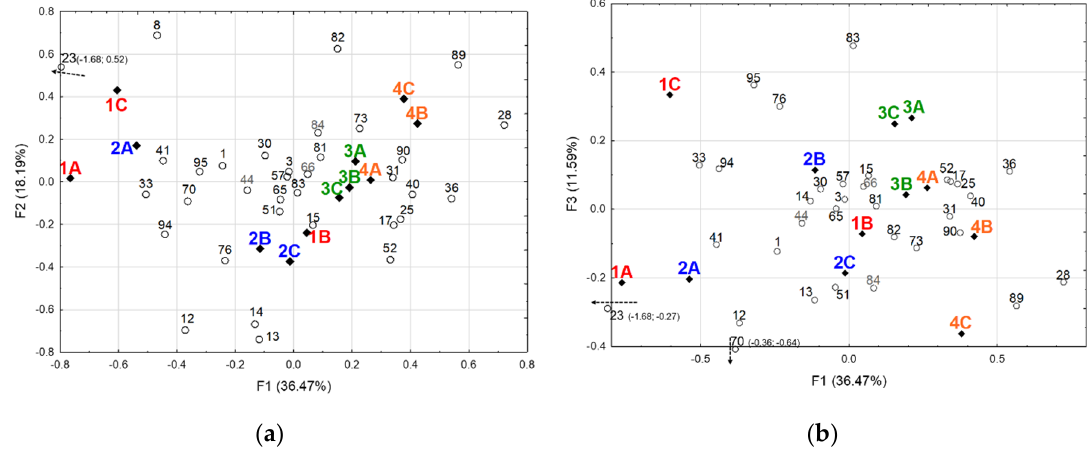
Figure 1. Correspondence analysis (CA) between the 12 samples and the 34 discriminant OAs defined by their NIF values. OAs (light circles) are plotted according to their NIF in samples (plain diamonds) in the dimensions 1 and 2 that gathered 54.66% of cumulative inertia ( a ), and 1 and 3 ( b ), respectively. The CA plots are zoomed in for clarity, and the coordinates of extra variables (23 and 70) indicated in brackets with their direction. The OA numbers are those found in Table 1. The sample names are colored for illustrative purpose, with pole 1 samples appearing in red, pole 2 samples in blue, pole 3 samples in green, and pole 4 ones in orange. A 3D plot (dimensions 1, 2, and 3) of the CA may be found in Appendix B (Figure B1). CA independence test: Khi² = 5444 (critical value 408, α = 0.05, degrees of freedom = 363), p < 0.0001.